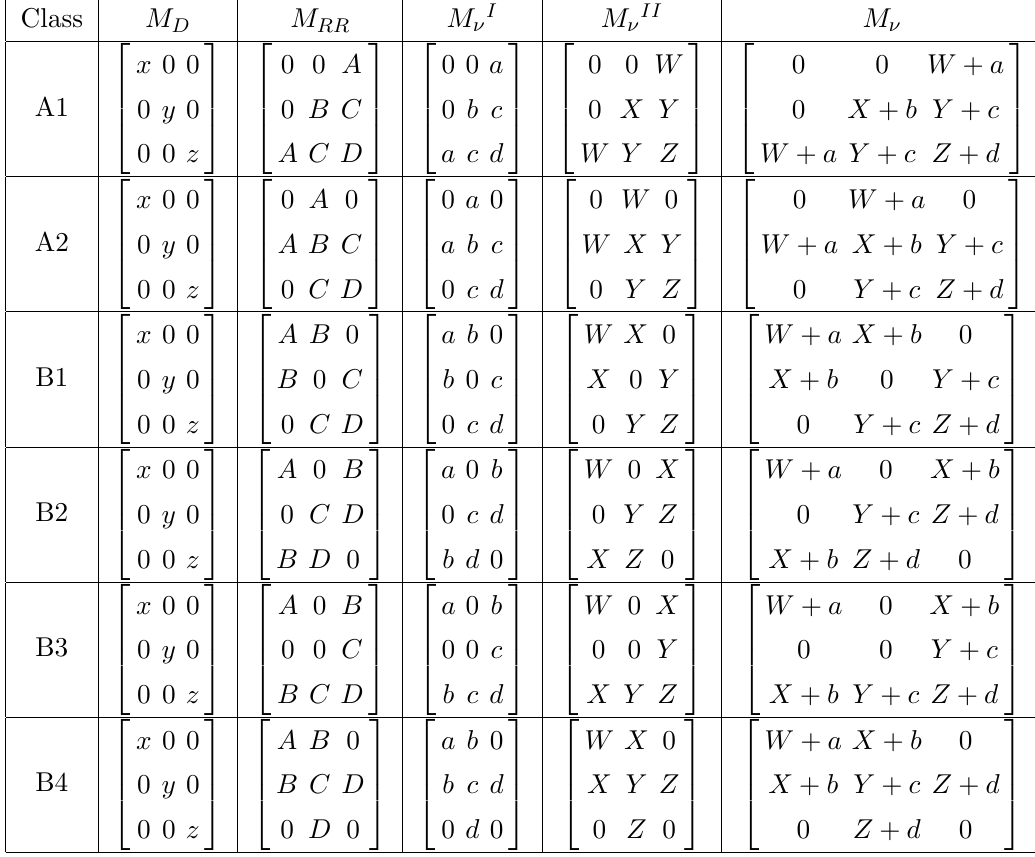
Table 7 . The structures of M D , M RR , M (cid:23) I and M (cid:23) II and M (cid:23) for di(cid:11)erent classes of two zero